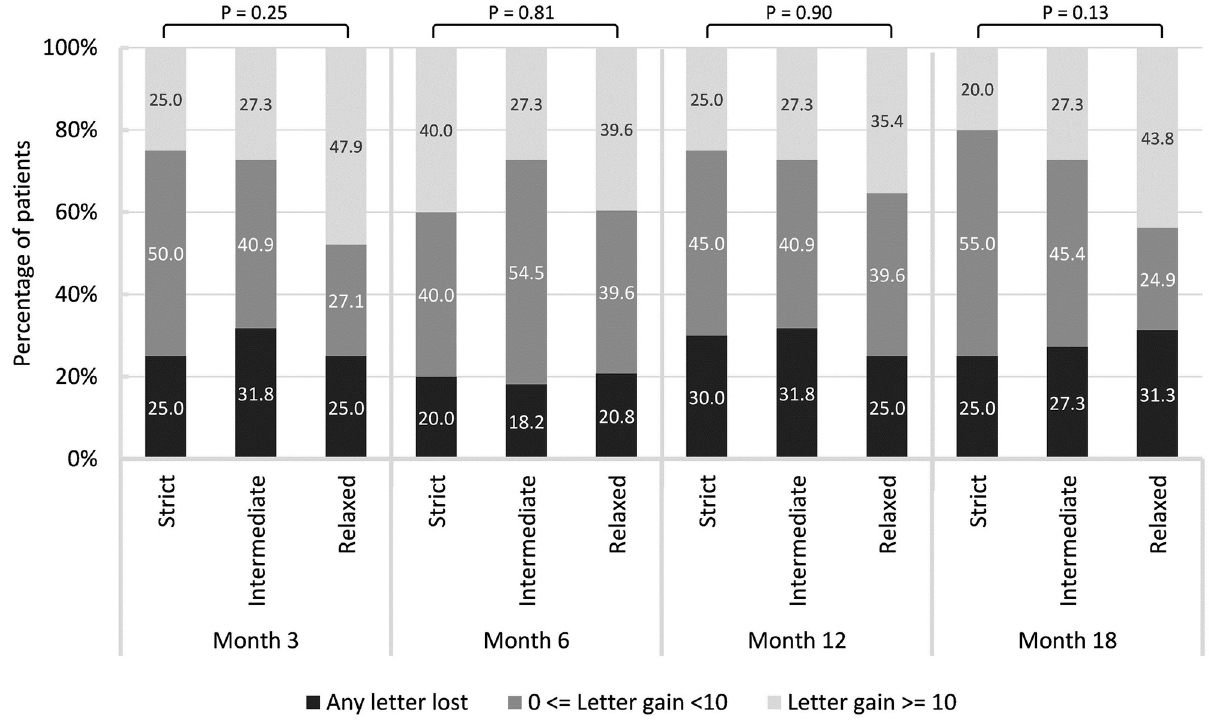
Fig 3. Changes in BCVA among the strict, intermediate, and relaxed groups, measured in terms of letters at various time points.